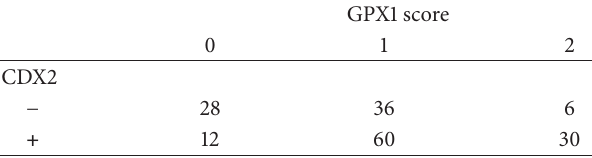
Table 4: Association of GPX1 with CDX2. GPX1